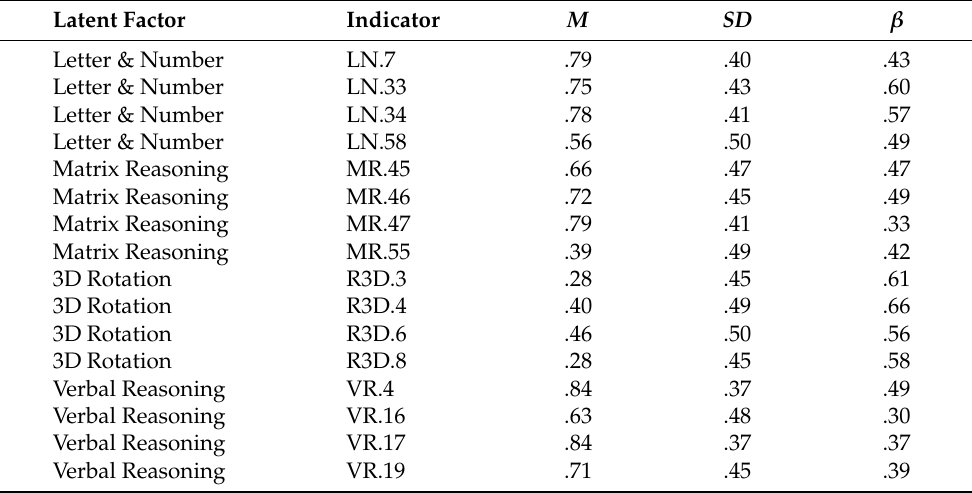
Table A1. Descriptive statistics and standardized factor loadings ( β ) of each ICAR-16 item on its own latent factor in the current sample. All loadings are significant at p <